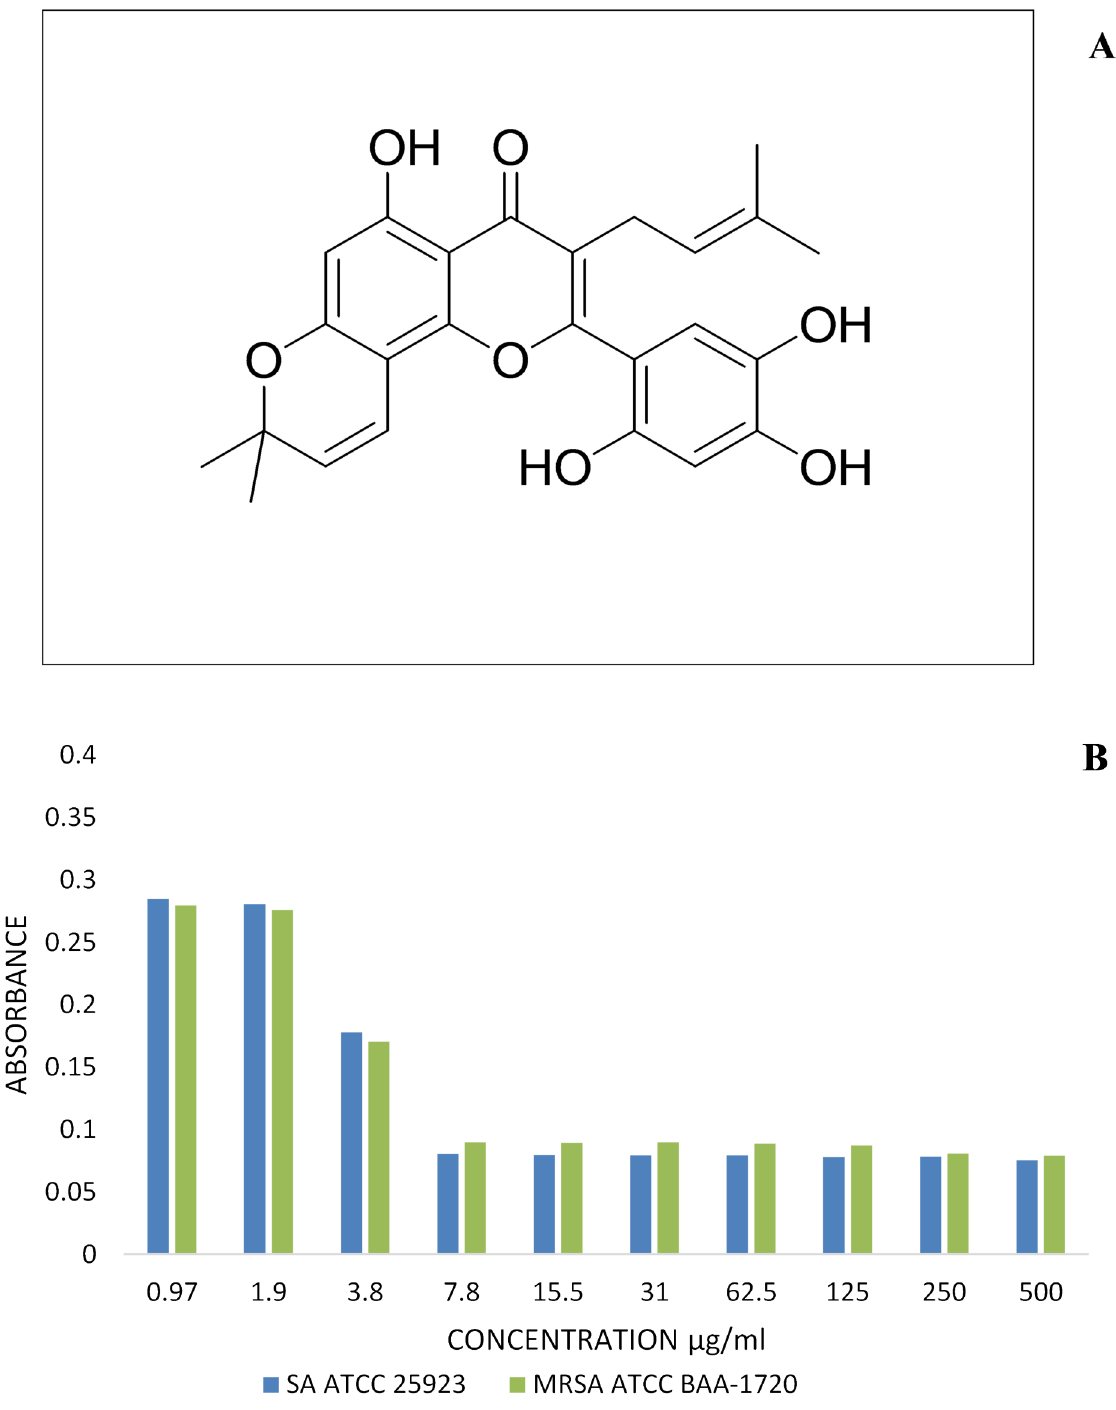
Fig 4. Artonin E bacterial growth and survival. (A) Chemical structure of artonin E. (B) Alamar Blue viability assay showing inhibition of growth of S . aureus ATCC 25923 and MRSA ATCC BAA-1720 strains in the presence of various concentrations of artonin E incubated in nutrient broth medium at 37°C for 24